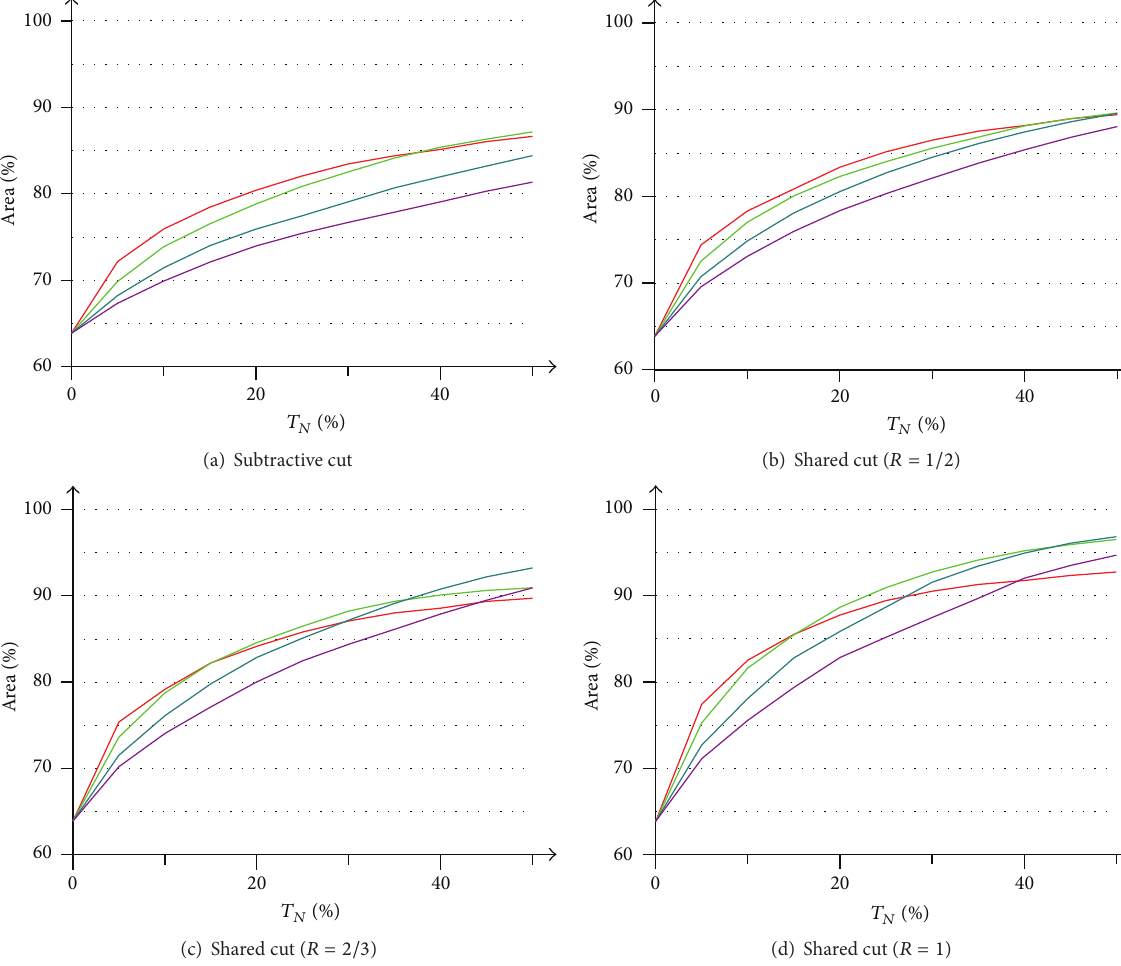
Figure 5: Percentage of covered area. Colors represent several 𝑅 𝑁 values: 1/4, 1/3, 1/2, and